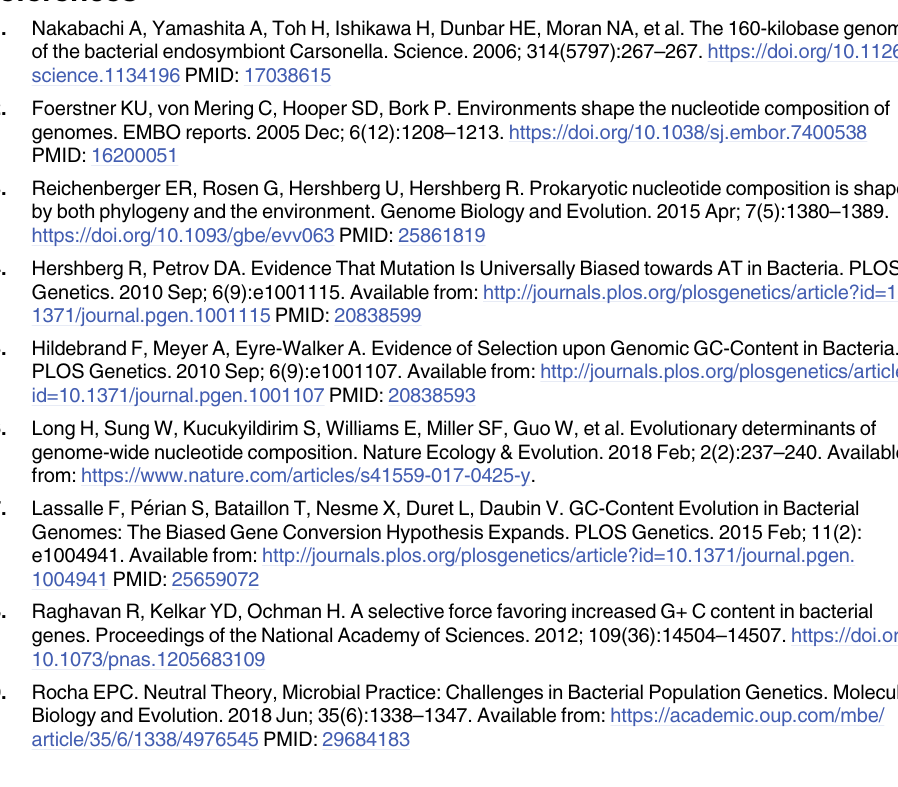
S11 Fig. Most species in RefSeq tend to always encode or always lack Ku on their genomes. Shown is the proportion of genomes within a species that have Ku (all RefSeq assemblies) plot- ted against the total number of assemblies in RefSeq for that species. S12 Fig. We evaluate the use of polymorphisms as a proxy for mutation by comparing esti- mates for the few species present in both the polymorphism and mutation accumulation data. (a) Estimates based on all polymorphisms. (b) Estimates based on polymorphisms at fourfold degenerate sites. Here we see selection/BGC appears to bias the polymorphism esti- mates when mutation is extremely biased towards